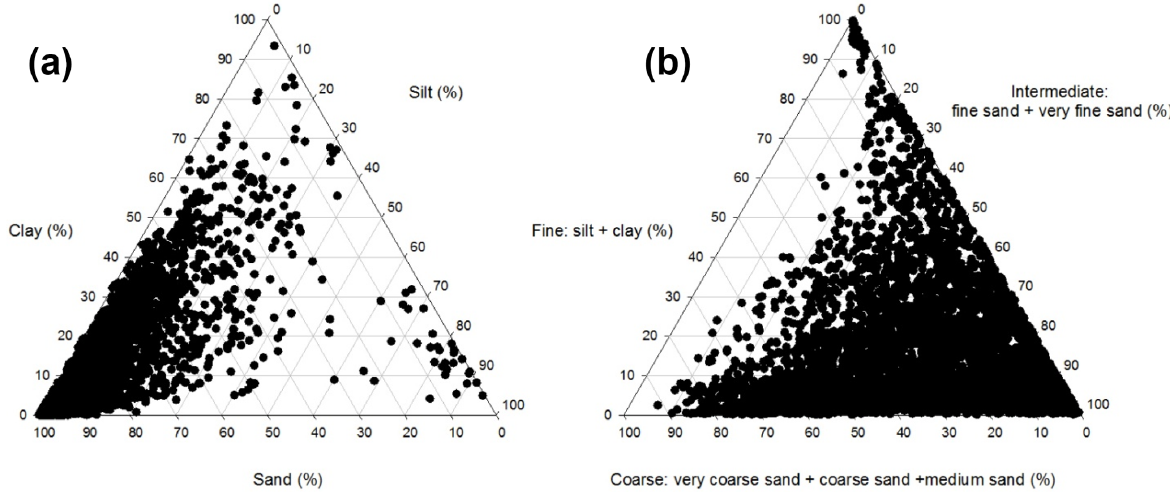
Figure 1. Texture of soil samples in the database shown in the standard USDA (a) and modified 3–2–2 textural triangles (b) .